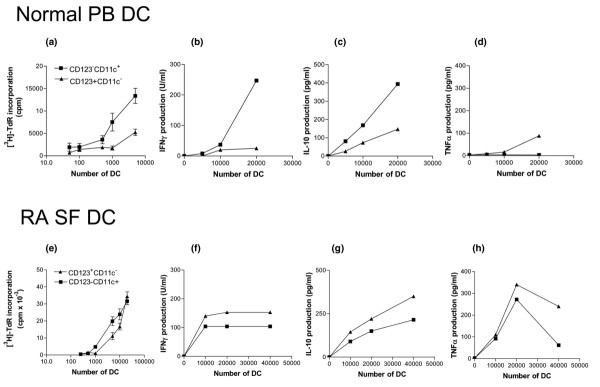
CD123+ and CD11c+ synovial fluid (SF) dendritic cells (DCs) are efficient antigen-presenting cells (APCs) and induce secretion of tumor necrosis factor α. Freshly sorted CD123+CD11c- or CD11c+CD123- DCs from either normal peripheral blood (PB) (a–d) or rheumatoid arthritis (RA) SF (e–h) were incubated with 105 purified normal allogeneic T cells. T-cell proliferation was measured by [3H]thymidine incorporation of triplicate wells after 60 hours (a, e). Unstimulated T-cell proliferation was routinely <500 cpm. Data represent means ± standard error of the mean of triplicate wells and are from three individual PB and SF donors. The concentrations of IFNγ, IL-10, and tumor necrosis factor (TNF)-α were measured in supernatants of allogeneic mixed lymphocyte reactions stimulated by sorted PB (b–d) or SF DCs (f–h). Data are means of duplicate samples and are from two separate SF donors.